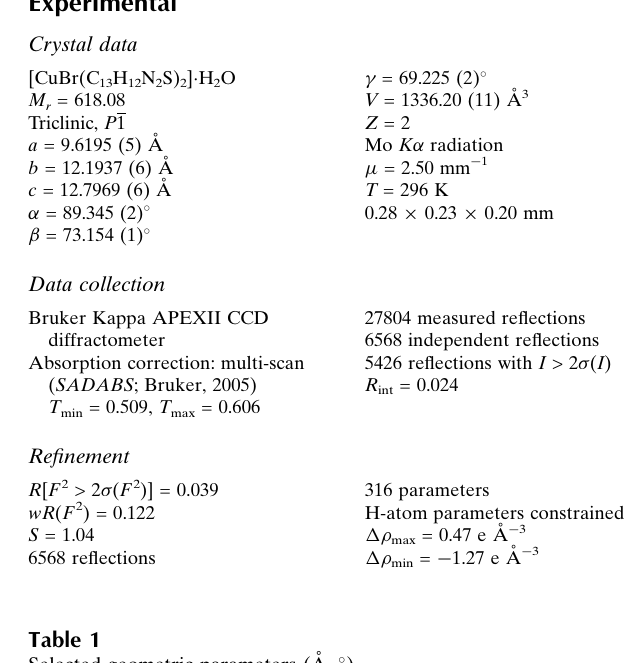
Selected geometric parameters (A˚ , (cid:3) ).